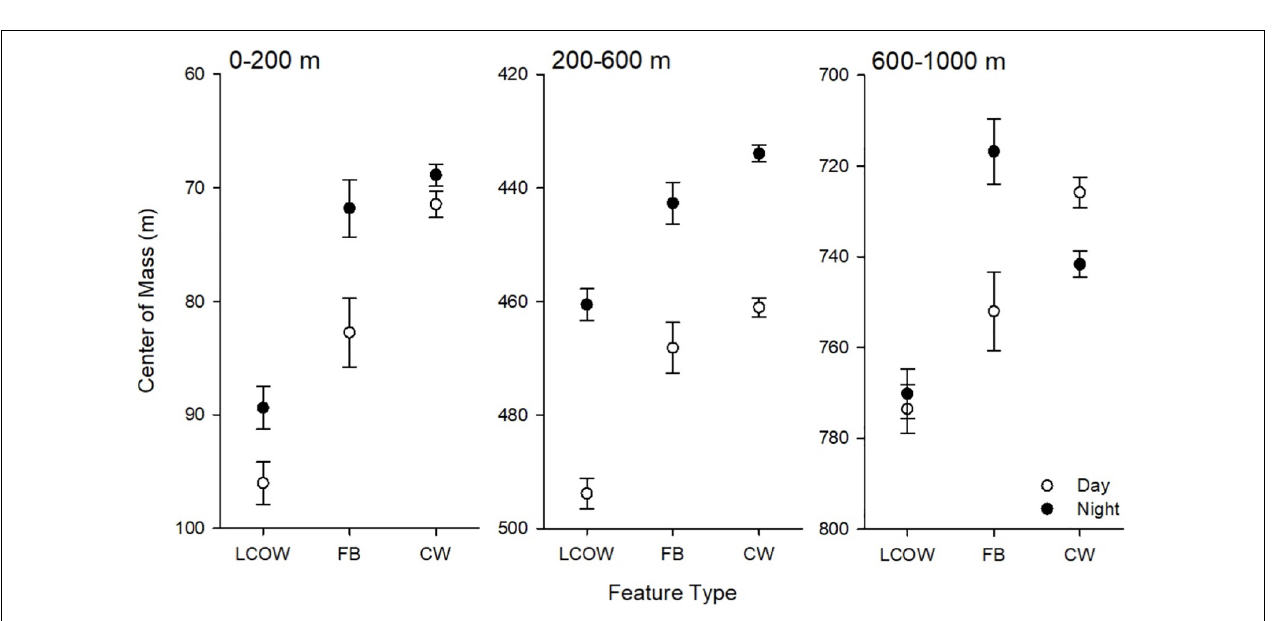
FIGURE 4 | Least-squared means of center of mass by feature class, time of day (open symbols are day, filled are night) and depth interval. LCOW, Loop Current-origin water; FB, frontal boundary; and CW, Gulf Common Water. Error bars represent standard error from least-squared mean estimates.